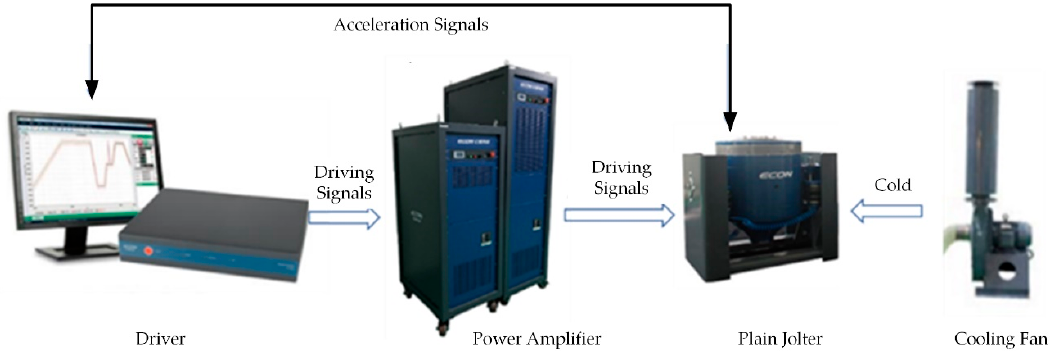
Figure 10. The dynamic frequency sweeping system of the plain jolter.